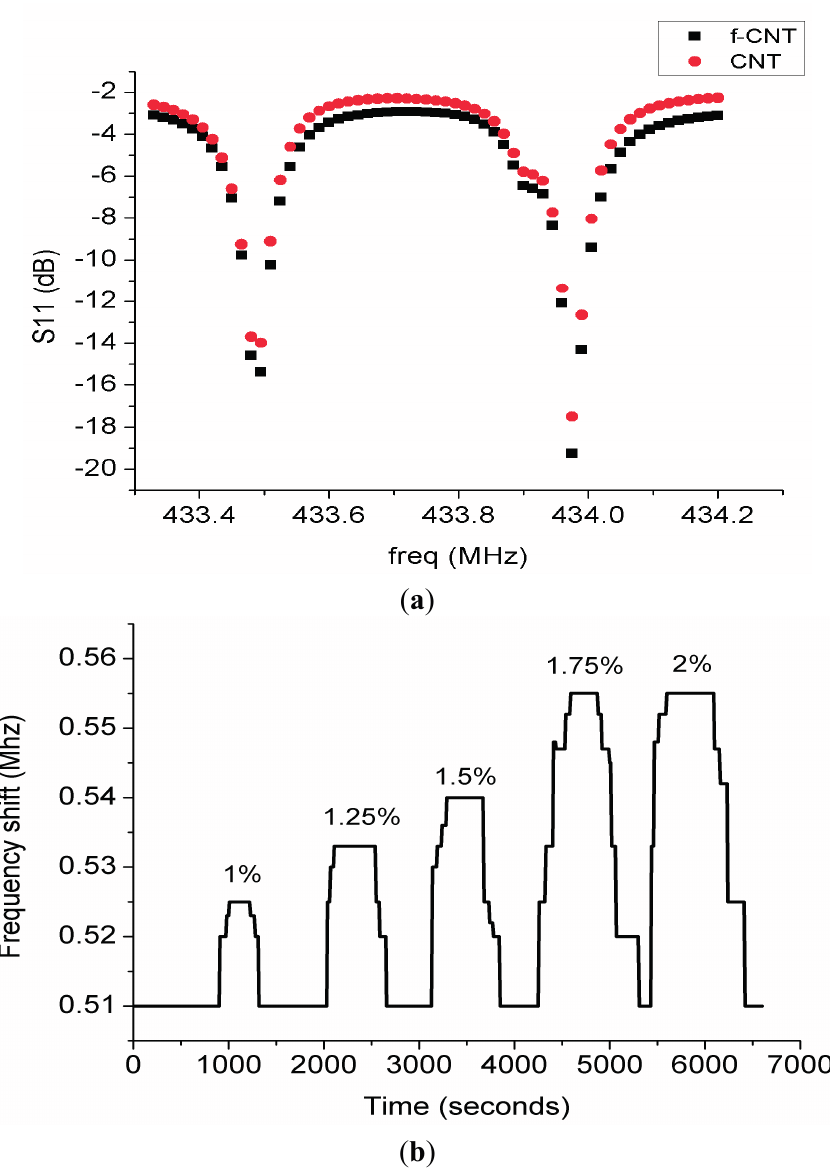
Figure 10. ( a ) Response of CNT and functionalized CNT to hydrogen gas; ( b ) Plot of frequency shift versus time for different hydrogen gas